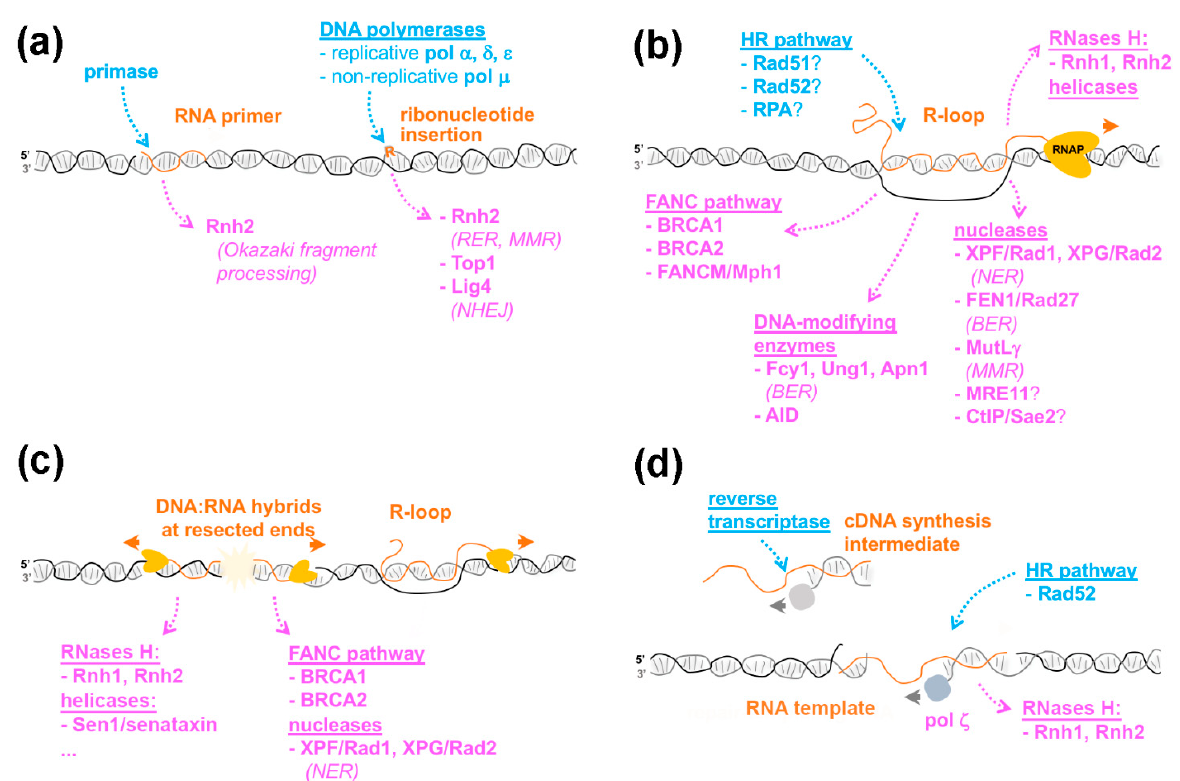
Figure 1. The variety of RNA-containing structures in the genome. Different types of ribonucleotide- or RNA-containing structures are represented in orange. The enzymes with reported contributions to their generation or removal are listed in blue and magenta, respectively, and the repair pathways with which they are associated are italicized. The orange and grey arrows indicate the direction of RNA and DNA synthesis, respectively. RNAP, RNA polymerase. ( a ), Ribonucleotide incorporation during DNA replication. For simplicity, only one branch of the replication fork is represented. ( b ), R-loop formation and resolution. ( c ), DNA:RNA hybrid accumulation at DSBs. ( d ), RNA-templated DNA repair. The cDNA produced upon reverse-transcription can also be used in homology-directed repair in a Rad51- and Rad52-dependent process (not depicted). See text for details.